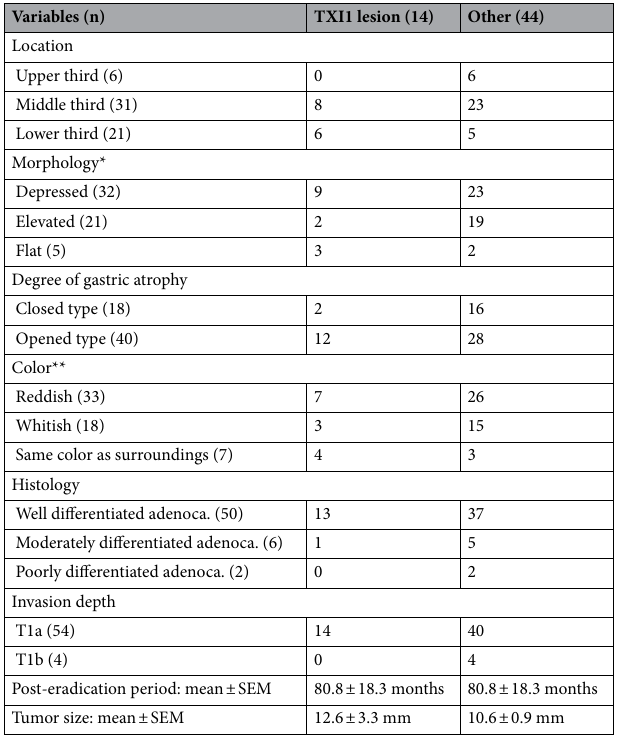
Table 4. Association between usefulness of TXI1 endoscopy and clinicopathological characteristics of gastric tumor. TXI1 lesions, lesions at least one trainee could not detect lesion by the WL but all trainees could detect lesion by using the TXI1; adenoca., adenocarcinoma. *Flat vs. others, P = 0.05; **same as surroundings vs. others, P = 0.03. Categorical and continuous variables were determined using the Chi-squared test and the student’s t test, respectively. Post-eradication period was not determined for five